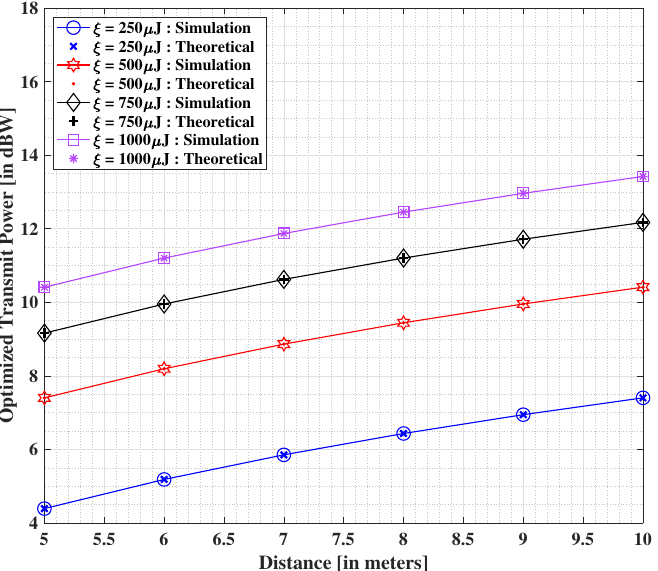
Figure 6. Minimized transmit power (in dBW) versus the demanded harvested energy, with N = 5000